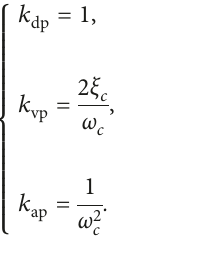
Figure 10: 6-DOF vibration representation test bed of a vehicle.